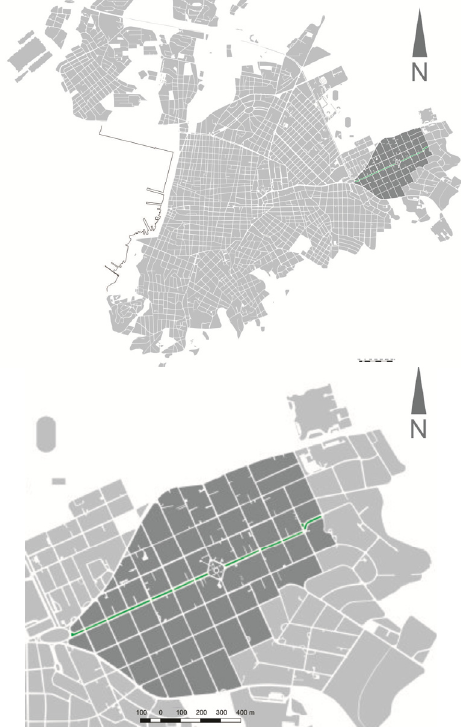
Figure 1. Location of Vista Alegre in Santiago de Cuba and detail of urban pattern